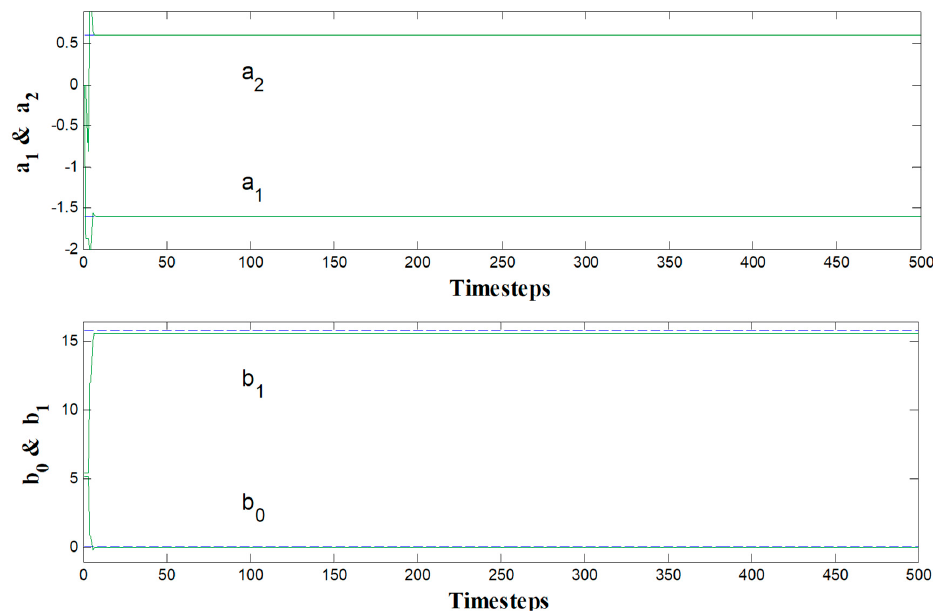
Figure 8 . Parameter estimates for non-minimum phase system without zero cancellation. Figure 8. Parameter estimates for non-minimum phase system without zero